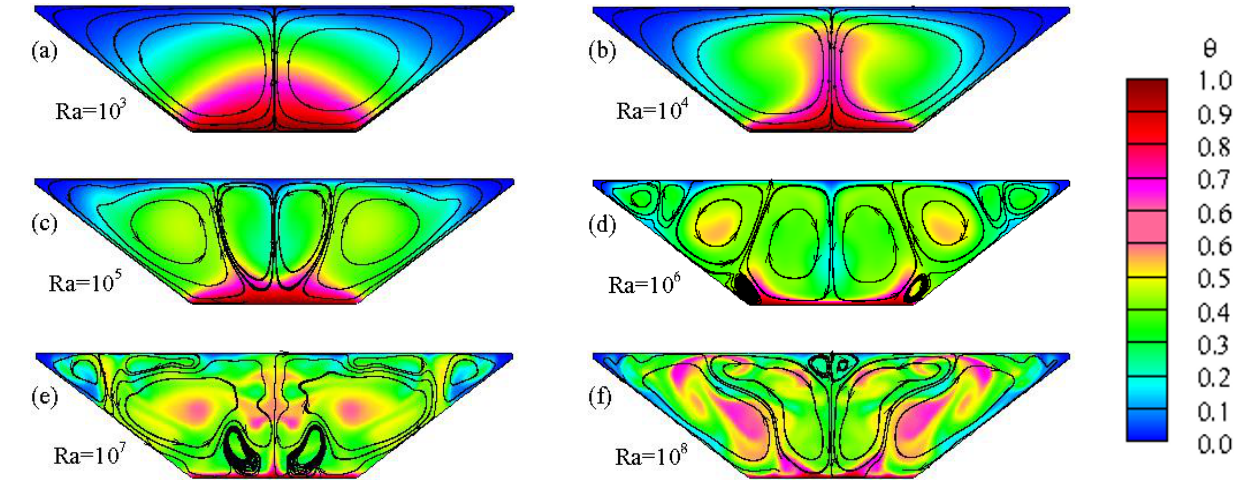
Figure 5. Streamlines and isotherms at the initial transitional stage for the different Rayleigh numbers ( a ) Ra = 10 3 , ( b ) Ra = 10 4 , ( c ) Ra = 10 5 , ( d ) Ra = 10 6 , ( e ) Ra = 10 7 , ( f ) Ra = 10 8 , at τ = 20.